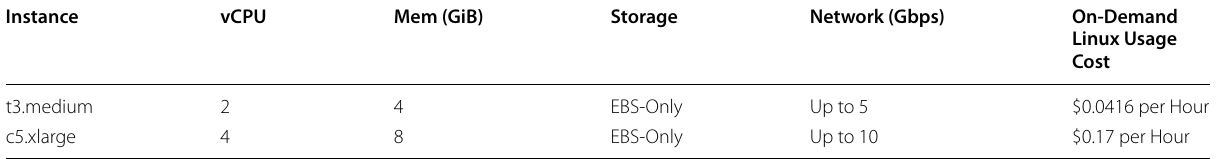
Table 1 Overview of AWS instance resource sizing used in testing Instance vCPU Mem (GiB)